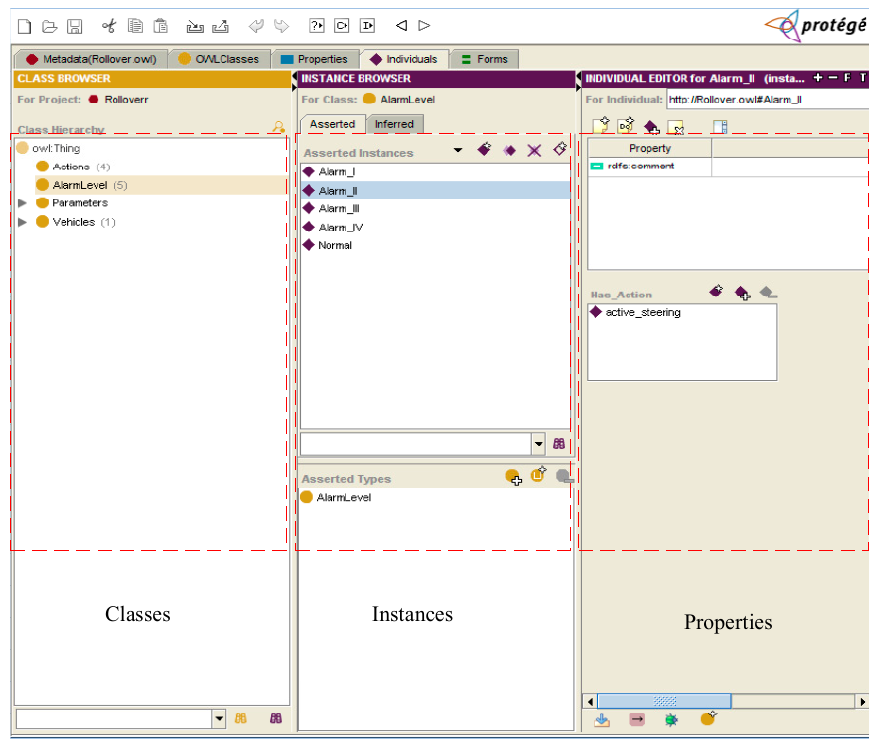
Figure 4. Rollover ontology model built using the Protégé software.